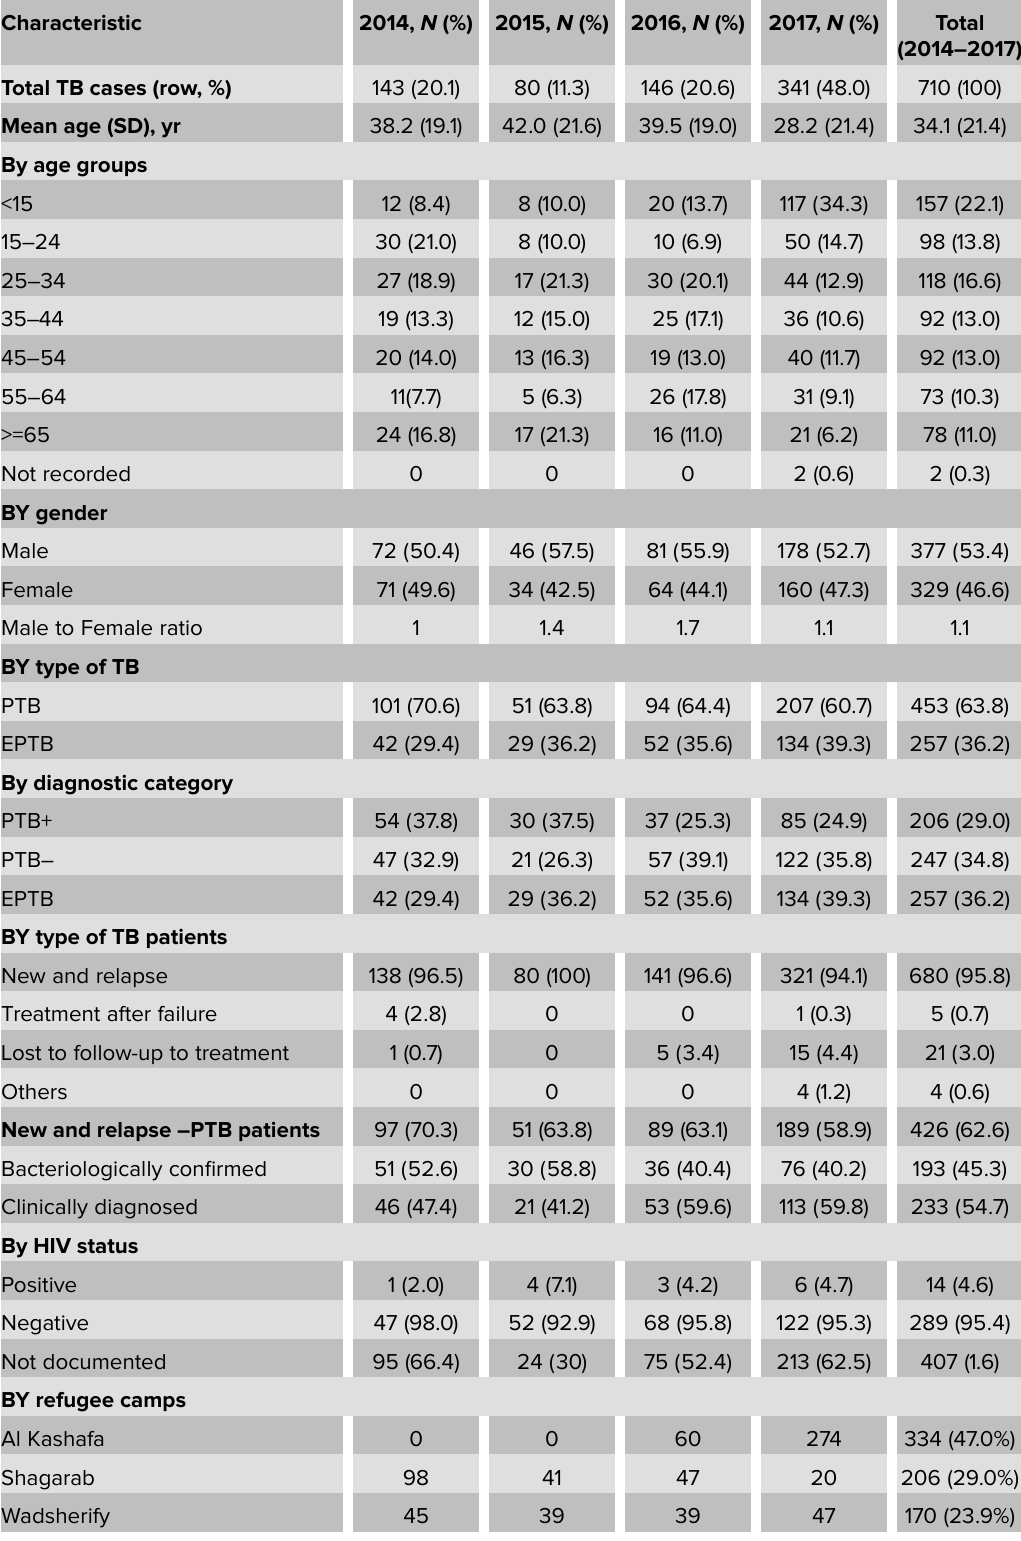
TABLE 1: Characteristics of notified TB cases in Al Kashafa, Wadsherify, and Shagarab refugee camps, Sudan, 2014–2017 ( N =